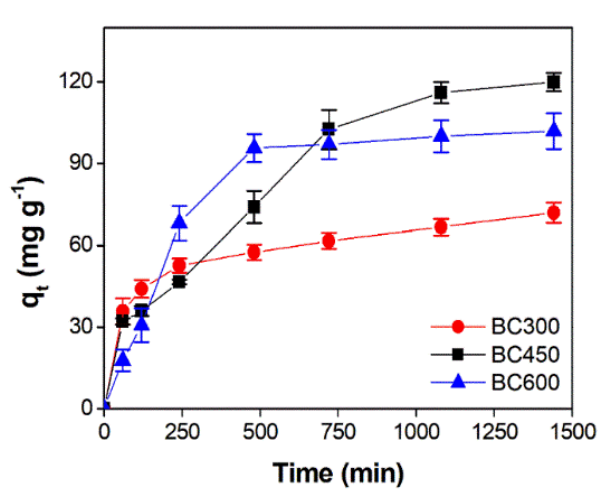
Figure 4. Cu 2+ removal kinetics of biochar samples under study (BC300, BC450, and BC600).